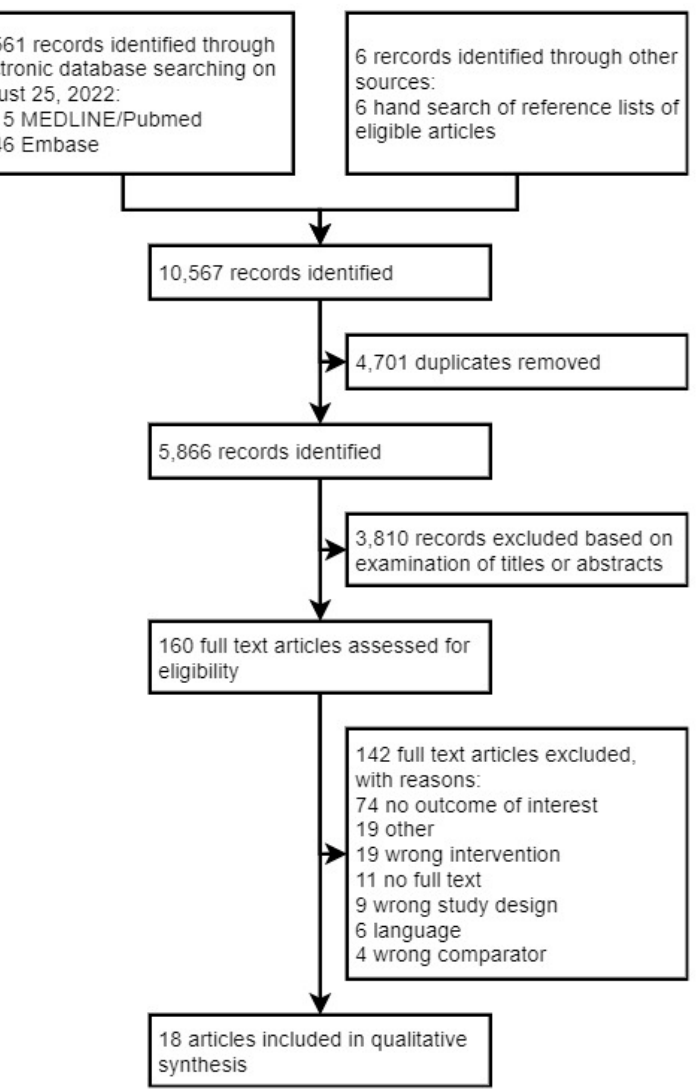
Figure 1. Study selection flow diagram according to the Preferred Reporting Items for Systematic reviews and Meta-analyses (PRISMA) guidelines.